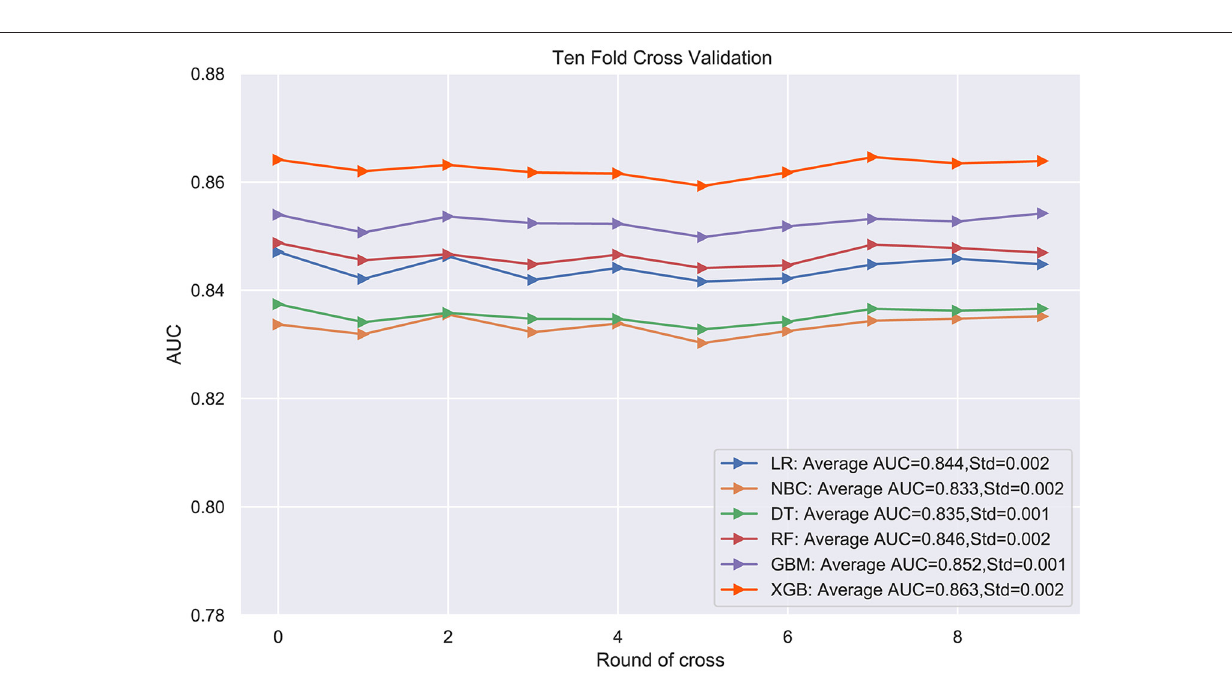
FIGURE 4 | Ten-fold cross-validation results of different machine learning models in the training set. DT, Decision tree; LR, Logistic regression; GBM, Gradient Boosting Machine; NBC, Naive Bayes classification; RF, Random Forest; XGB, Extreme gradient